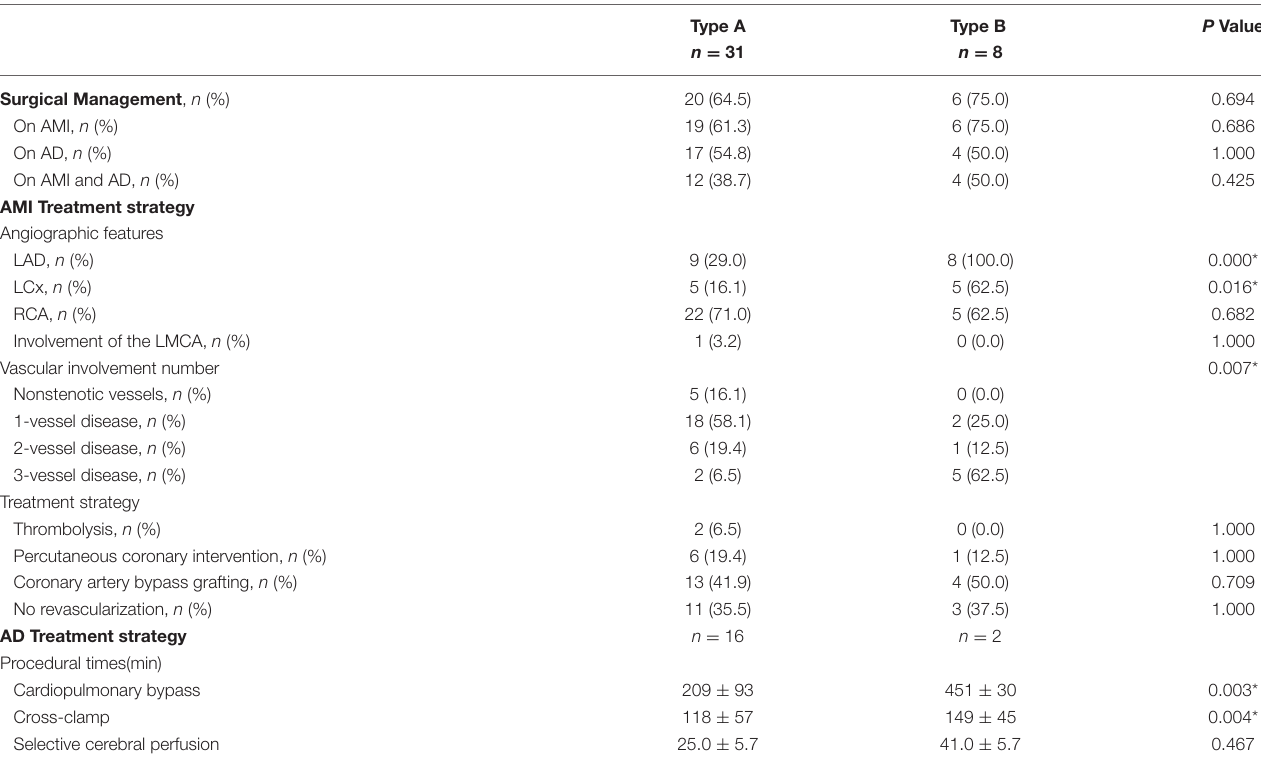
TABLE 3 | Angiographic features, and treatment